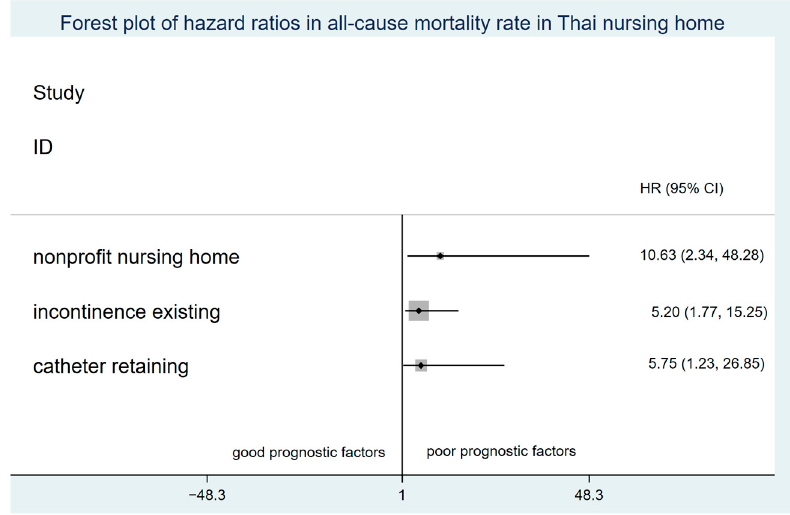
Figure 2. Forest plot of adjusted hazard ratios in all-cause mortality rate in Thai nursing homes.